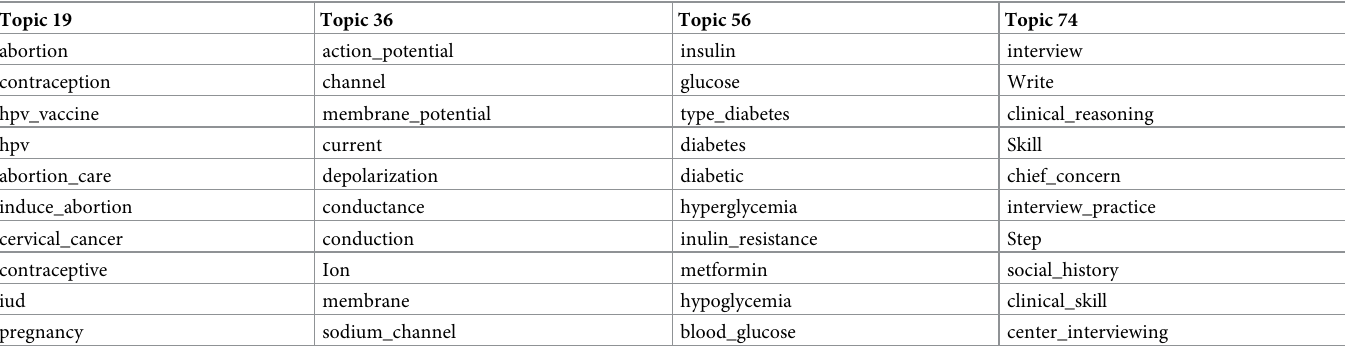
Table 1. Most relevant words for select